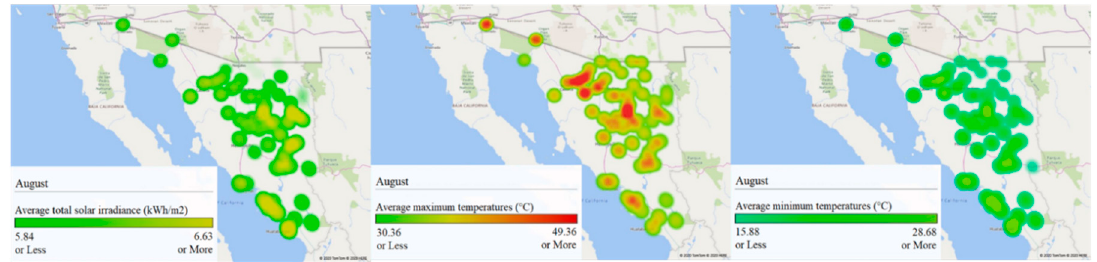
Figure 14. GIS analysis of Sonora for August: ( left ) average total solar irradiance (kWh/m 2 ), ( center ) maximum average temperatures (°C), and ( right ) minimum average temperatures (°C).